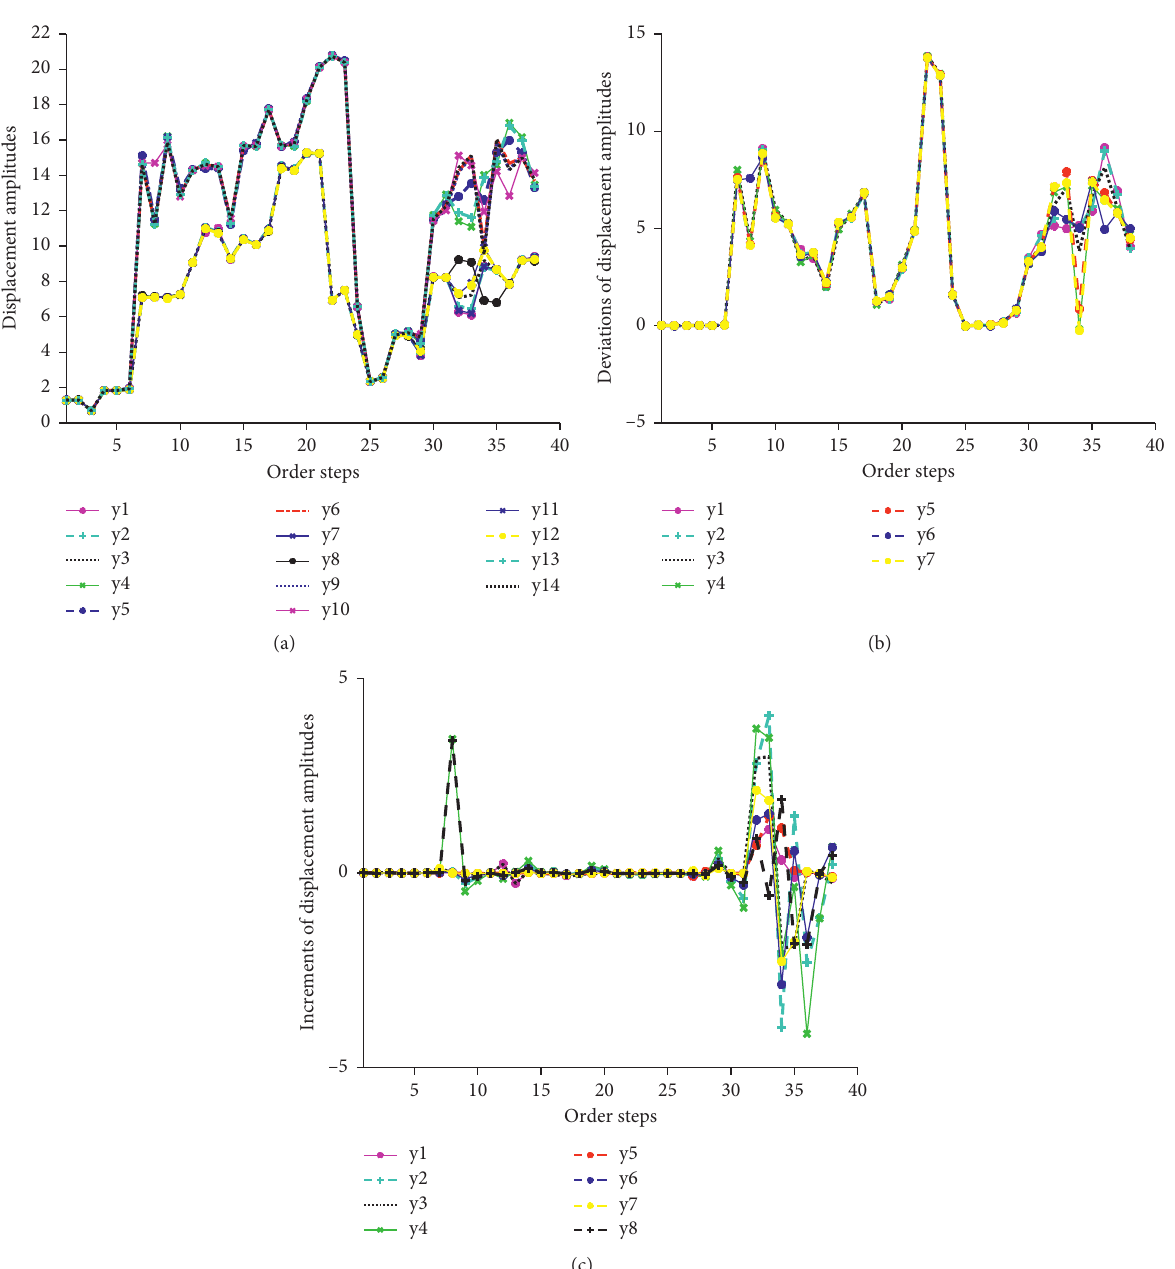
Figure 8: Displacement amplitudes with centrifugal force and thermal load. (a) Das. (b) Deviation of Das. (c) Variable quantity of